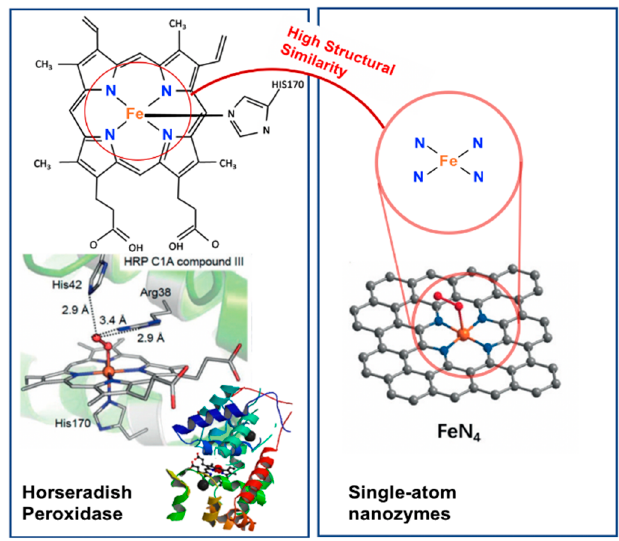
Figure 2. A comparison of the HRP enzyme and FeN 4 single-atom nanozyme showing the high structural similarity of the single-atom nanozyme to the active centre (iron-heme group) of HRP. (Adapted with permission from [64]. Copyright © 2017 Wiley-VCH Verlag GmbH & Co. KGaA, Weinheim, Germany).